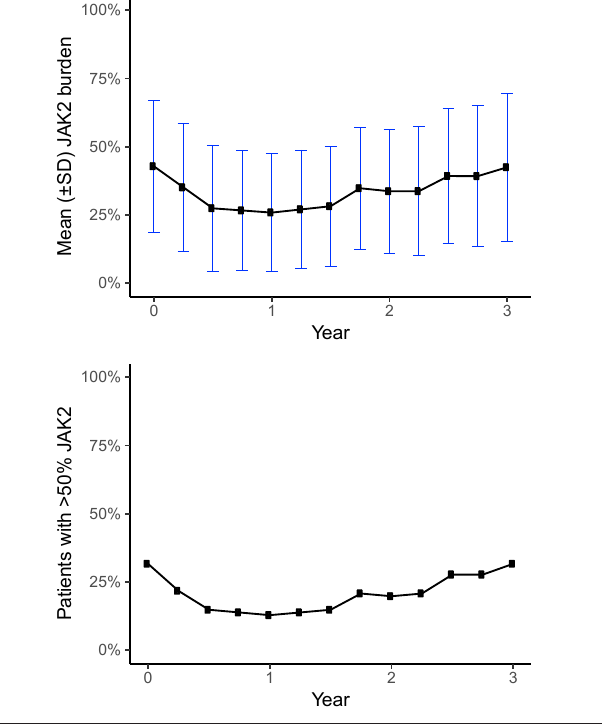
Table 2. Patient Population Characteristics of Validation Studies and Trial Malak et al. 2012 31 Bai et al. 2015 19 Alvarez-Larrán